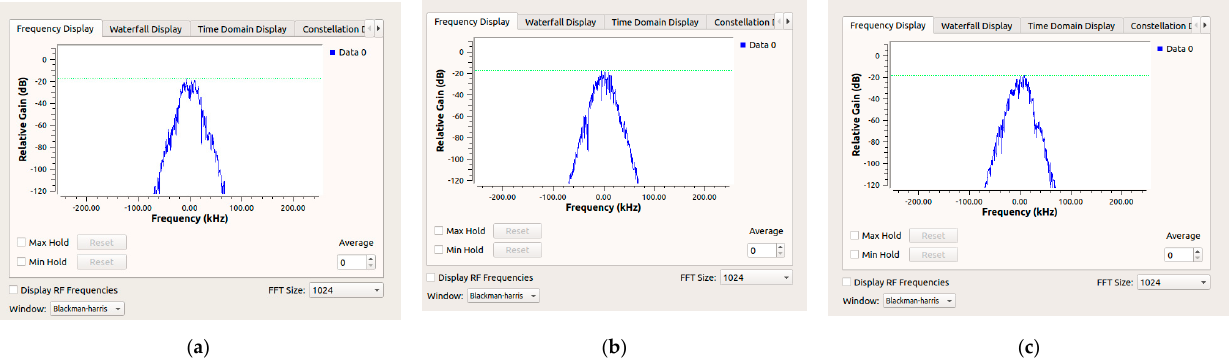
Figure 12. ( a – c ) The received signals of 2400 bps, 4800 bps and 9600 bps, respectively. The transmission channels are noiseless.